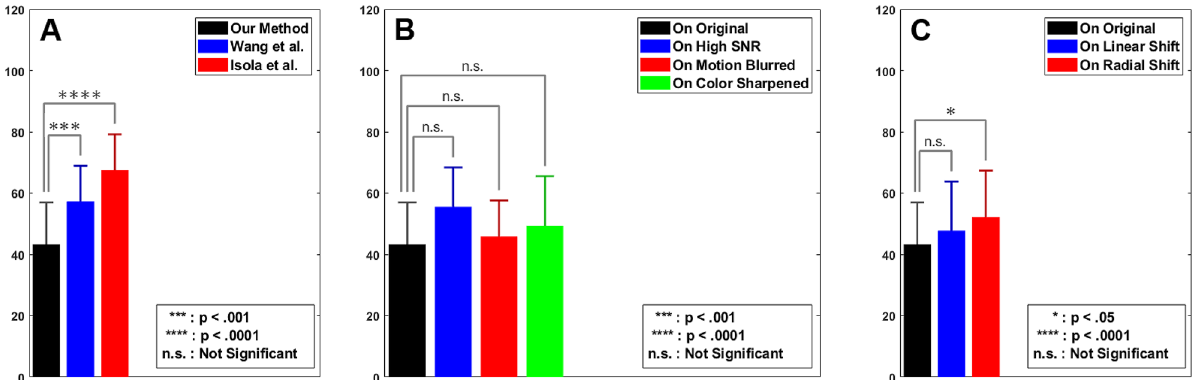
Figure 5. Comparison of the proposed deep learning FA generation model with the other GANs and under different conditions. ( A ) The FIDs for images generated by the proposed method compared with that of Wang et al. 50 and Isola et al. 27 —lower FID measures represent more accuracy. ( B ) FID measure of the images generated by the proposed on input fundus photographs taken under varying conditions—high signal to noise ratio (SNR), motion blur, and color sharpnening. ( C ) FID measure of the images generated by the proposed on input fundus photographs with slight anatomical alterations—translational vascular shift and rotational vascular shift.